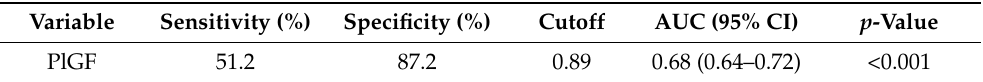
Table 2. Sensitivity, specificity, cutoff value, and area under the curve (AUC) of PlGF in the prediction and diagnosis of GDM.